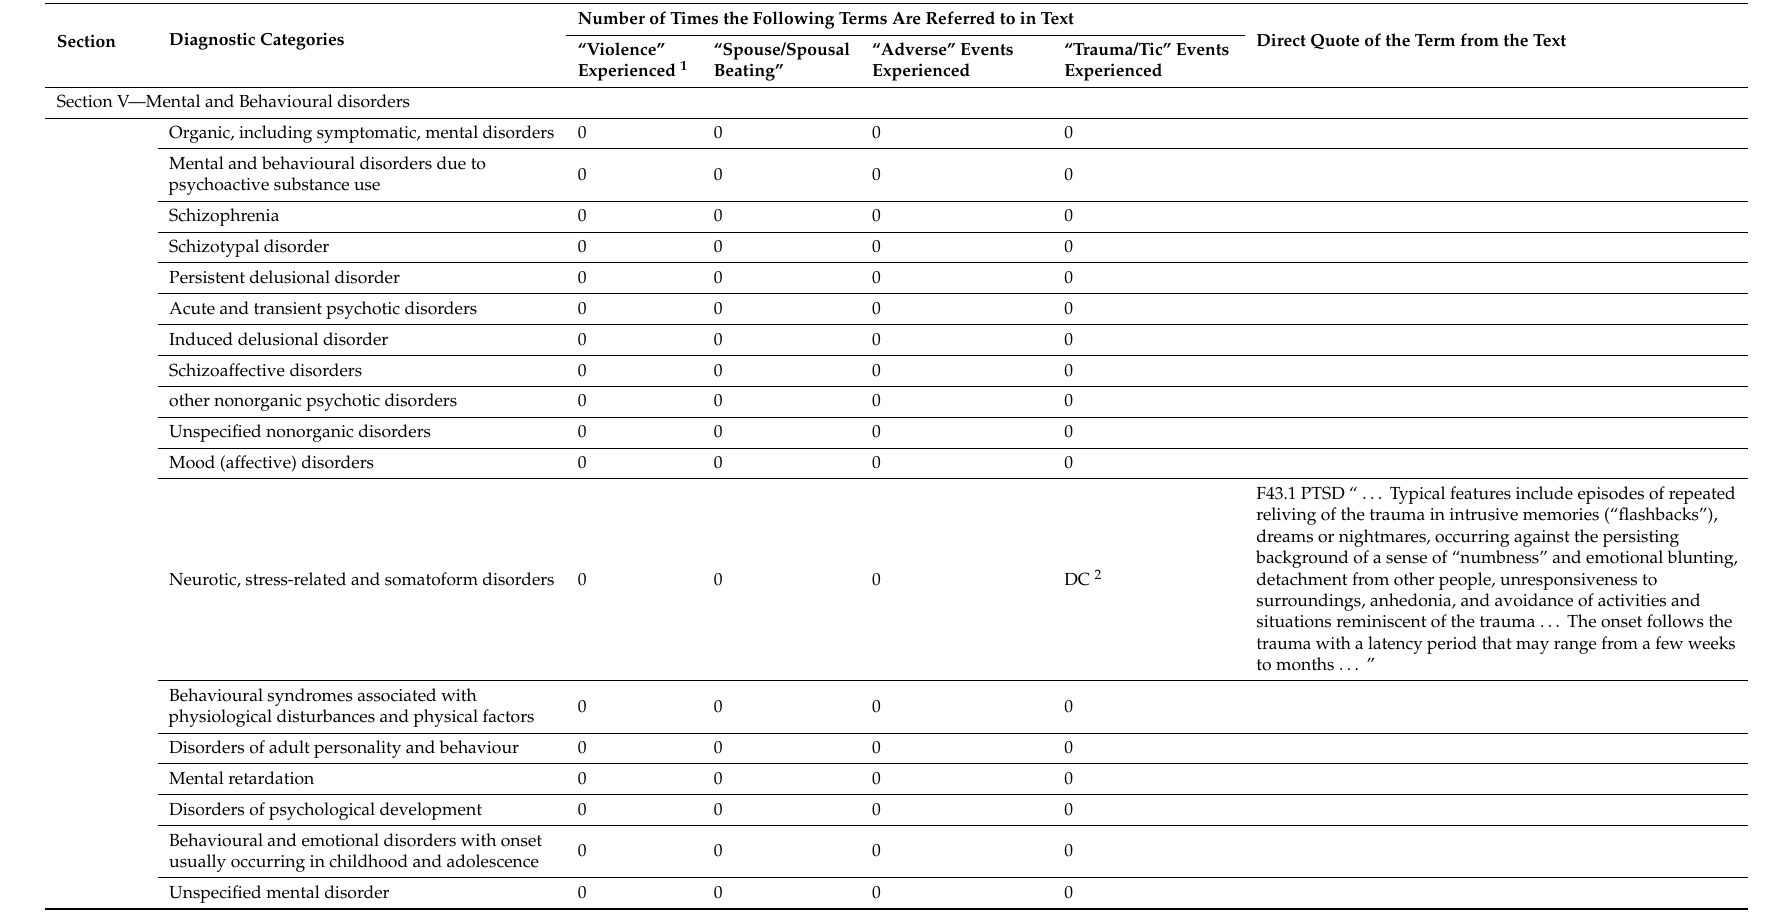
Table 2. Frequency of the terms “family violence”, “domestic violence”, “interpersonal violence”, “partner violence”, “violence”, “spouse/spousal beating”, “adverse” and “trauma/tic” in the context of family violence and events experienced or perpetrated in the ICD-10 2016 (online) Edition